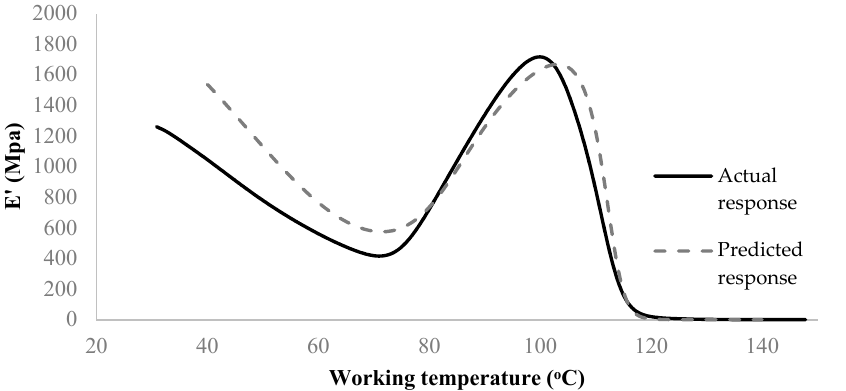
Figure 10. The performance of the developed 5-9-1 neural network to approximate the storage mod- ulus of the 3D prints.